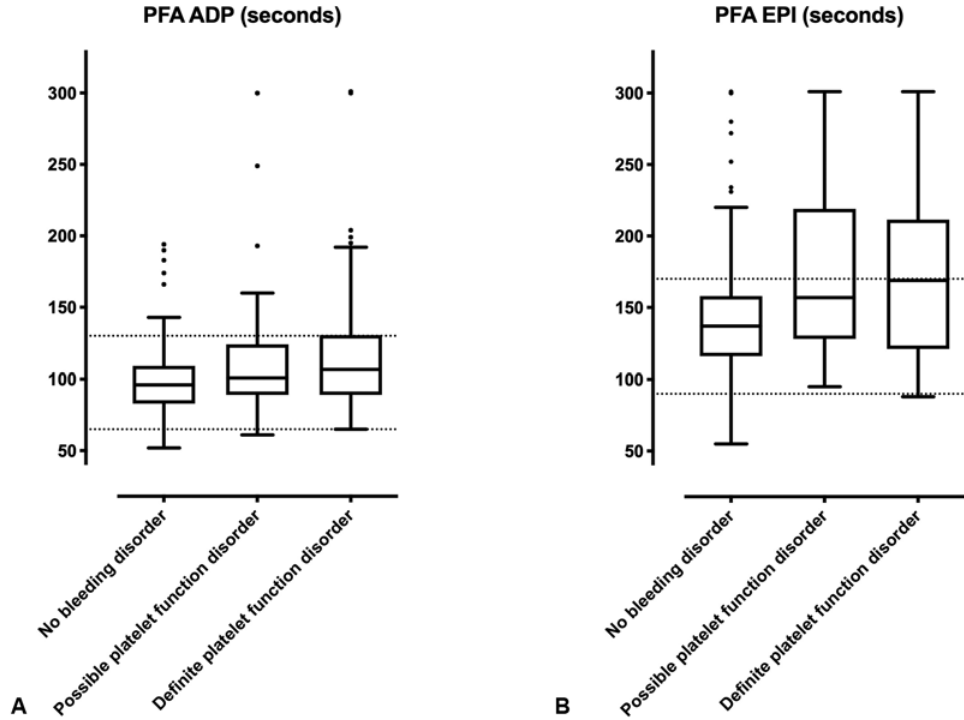
Fig. 2 Closure times of PFA according to the presence of a platelet function disorder. PFA was conducted in a cohort of 555 consecutive patients referred with a suspected bleeding disorder. Diagnosis of platelet function disorder was achieved using light transmission aggregometry and platelet fl ow cytometry.We de fi ned “ con fi rmedplateletfunctiondisorder ” as abnormal results inrepeated LTA/ fl ow cytometry measurementsin the absence of other disorders and “ possible platelet function disorder ” with an abnormal result in one measurement available, inconclusive results or presence of concomitant disorders. LTA, light transmission aggregometry. ( A ) PFA ADP measurements, ( B ) PFA epinephrine measurements.